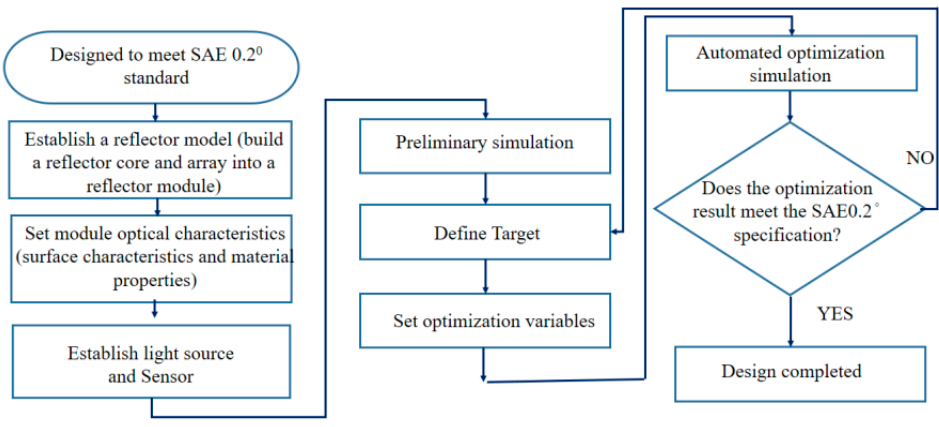
Figure 20. Reflector design flowchart.